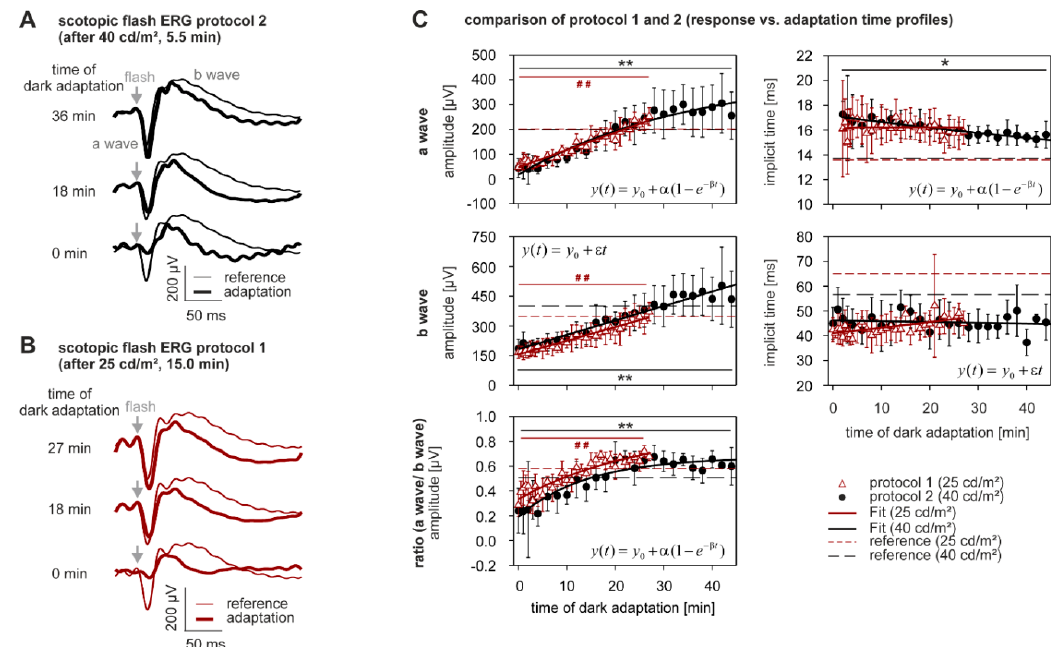
Figure 3. Dark adaptation—a- and b-waves. ( A , B ) Thick curves: scotopic flash ERGs (subject averaged) at different times after offset of the photopic adaptation. Thin curves: reference scotopic flash ERG recorded prior to photopic adaptation for comparison; ( C ) Amplitudes and implicit times vs. time of dark adaptation. The lower left plot shows the ratio of a- to b-wave amplitudes as a function of adaptation time. The dashed lines are values obtained from the reference measurements. n after 40 cd/m2 = 9, n after 25 cd/m 2 = 5.